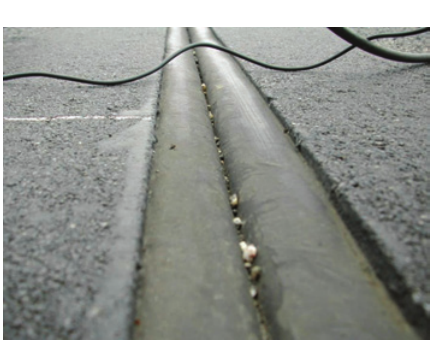
Fig. 4. The bridge movement joint on Bridge A